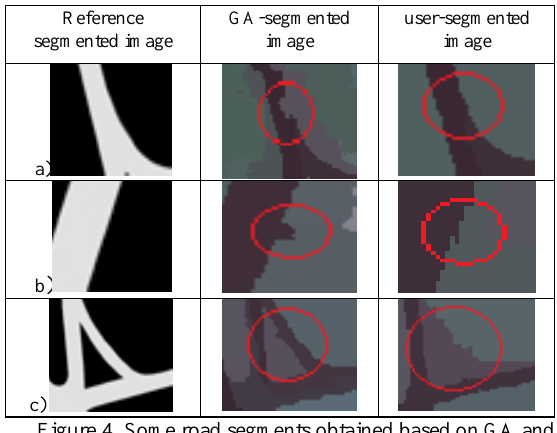
Figure 4. Some road segments obtained based on GA